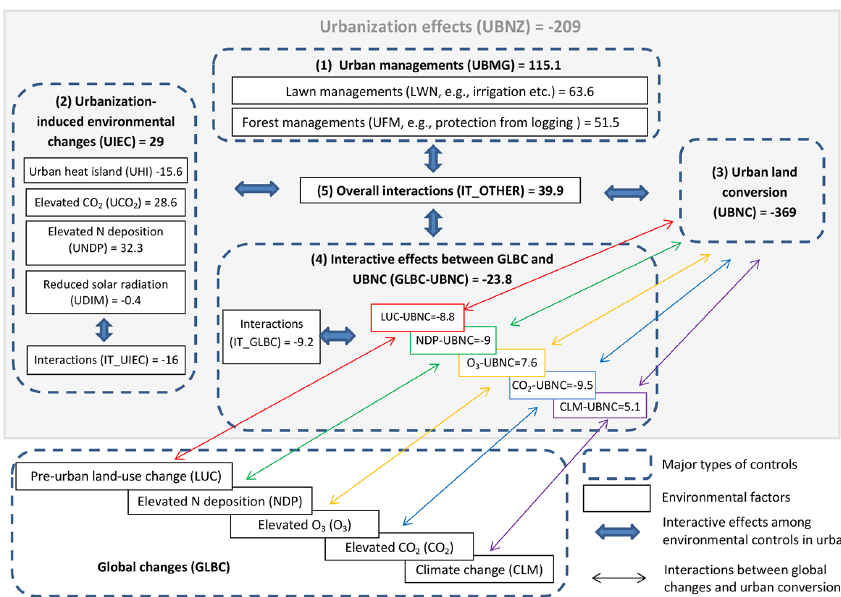
Figure 1. The urbanization (UBNZ) effects on regional carbon dynamics are controlled by four major types of environmental changes, including (1) urban land conversion (UBNC) during which rural land use type is converted to urban and developed land use composed by impervious surfaces, managed urban lawn, and other urban vegetation (e.g., urban forest); (2) urban management (UBMG), including lawn (LWN) management, such as irrigation and fertilization, and urban forest management, such as protection from logging and fire disturbances; (3) urbanization-induced environmental changes (UIECs), including effects of urban heat island (UHI), elevated CO 2 (UCO 2 ) and N deposition (UNDP), reduced solar radiation due to air pollution (UDIM), and interactions among these UIEC factors (IT_UIEC); (4) the interactive effects between UBNC and multiple global environmental changes (GLBC–UBNC), including changes in climate (CLM– UBNC), CO 2 (CO 2 –UBNC), N deposition (NDP-UBNC), ozone exposure (O 3 –UBNC), pre-urban land use change history (LUC–UBNC), such as cropland conversion and abandonment, and the interactions among all GLBC–UBNC factors. IT_OTHER represents the overall interactive effects among the four major controls (i.e., UBNC, UBMG, UIEC, and GLBC–UBNC). The numbers in the figure show the carbon flux in response to each factor from 1945 to 2007 in the southern United States. Unit: